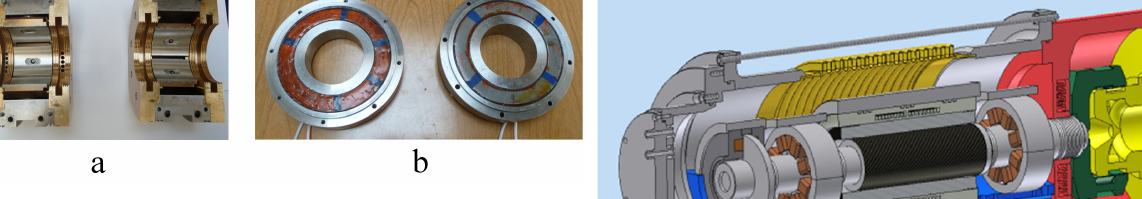
Figure 10: Oil-free bearings used in the 70 kW turbogenerator, a) hybrid journal bearing, b) thrust active magnetic bearing